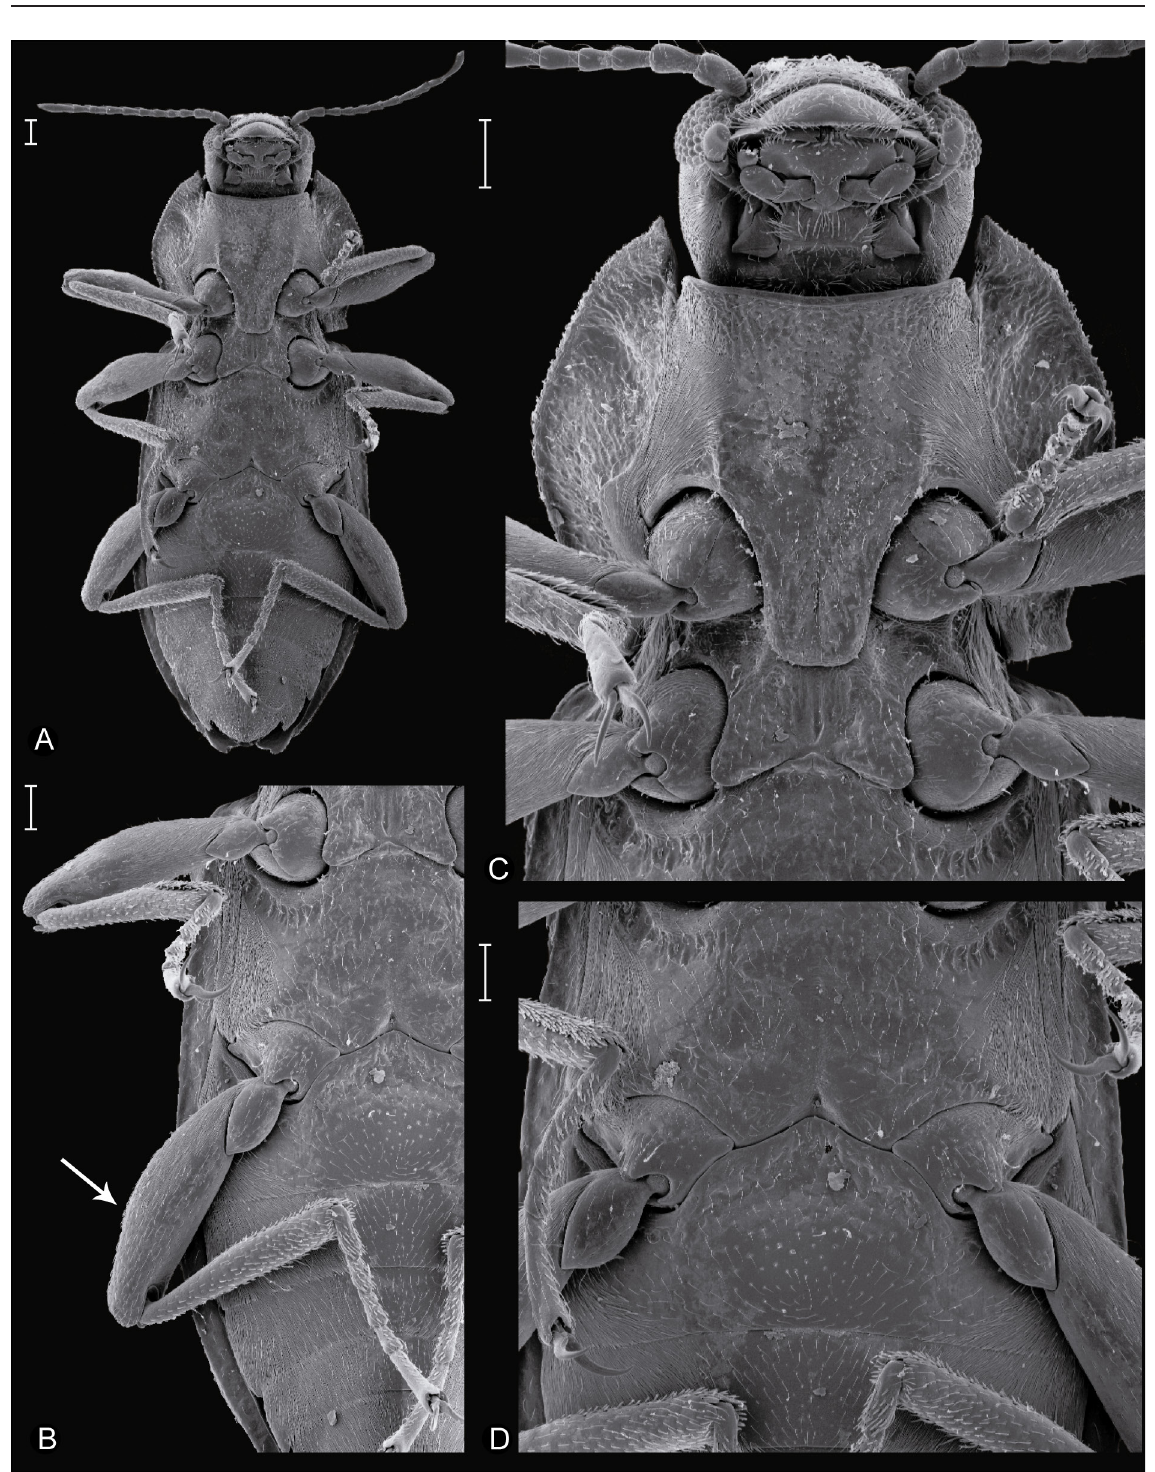
Fig. 7. Spanglerelmis xiririca Polizei & Bispo gen. et sp. nov. under scanning electron microscope, ♀ (MZSP31481). Ventral view. A . Habitus. B . Hind leg (arrow showing the pattern of tomentum on femur). C . Prosternum and mesoventrite. D . Metaventrite and abdominal ventrites I–II. Scale bars = 0.1